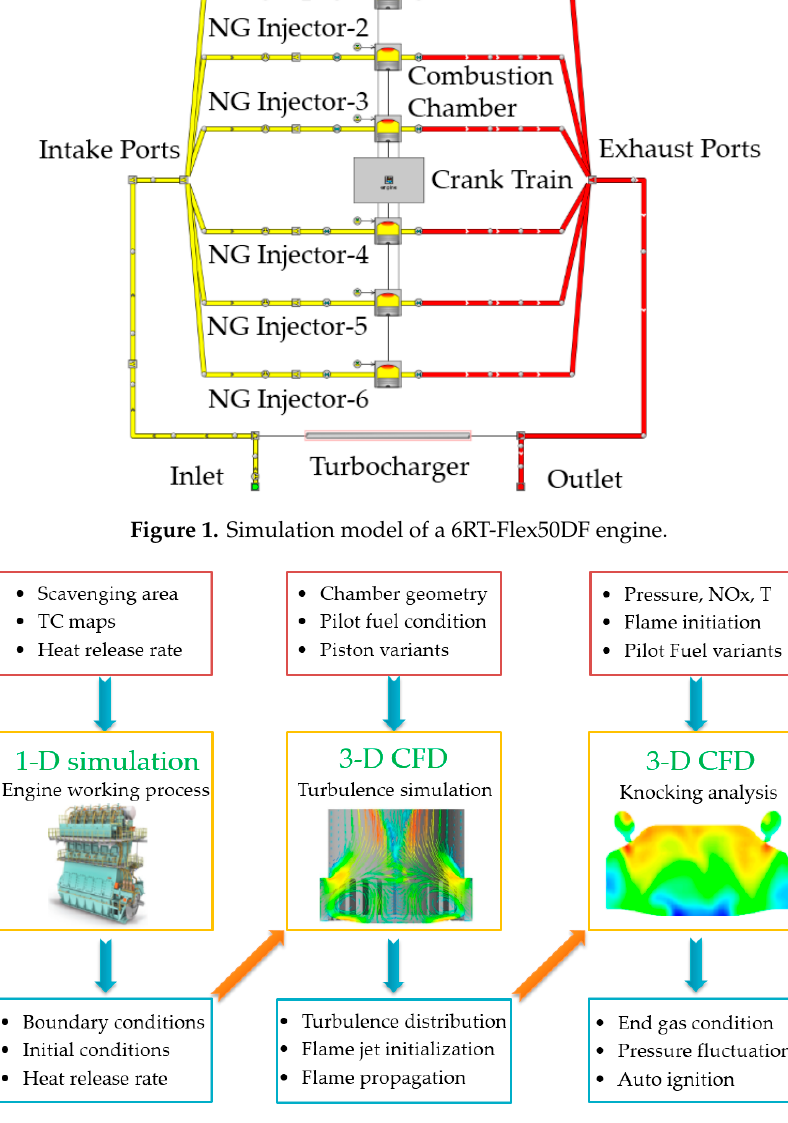
Figure 2. Schematic diagram of a low-pressure dual-fuel (LP-DF) engine simulation .